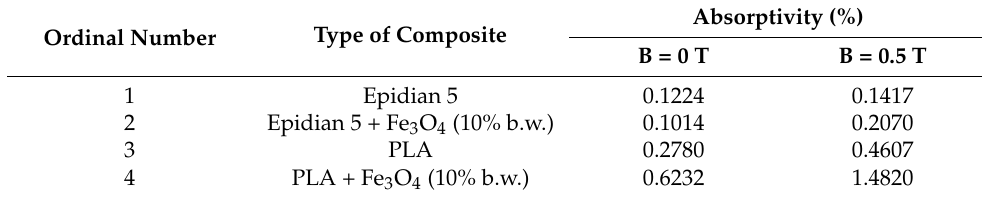
Table 3. Absorptivity of composites.